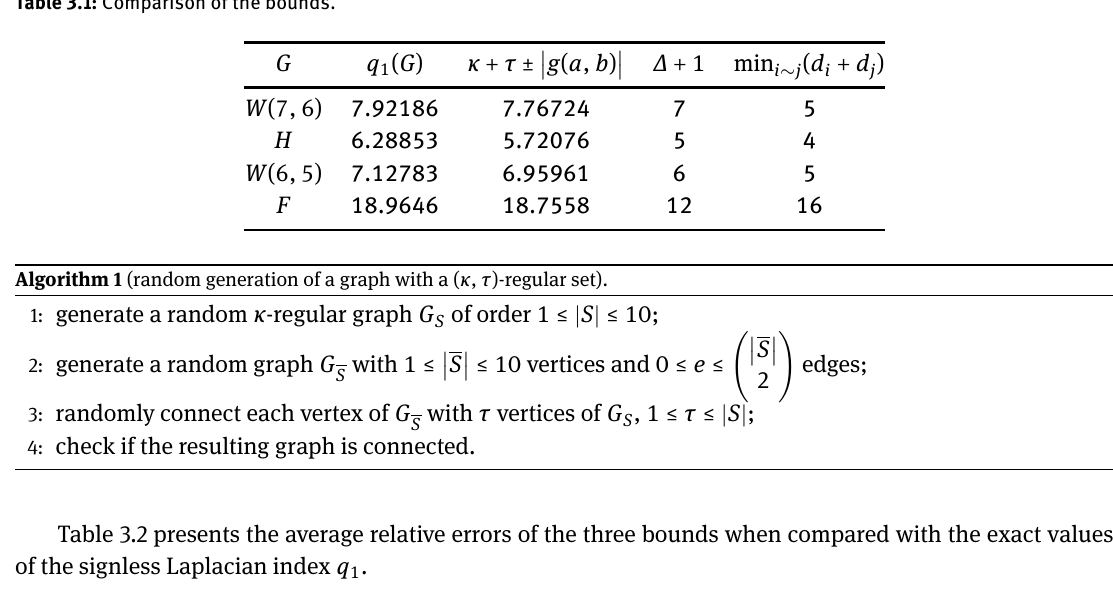
Table 3.2: Average relative errors of the lower bounds on the signless Laplacian index of the randomly generated graphs by the Algorithm